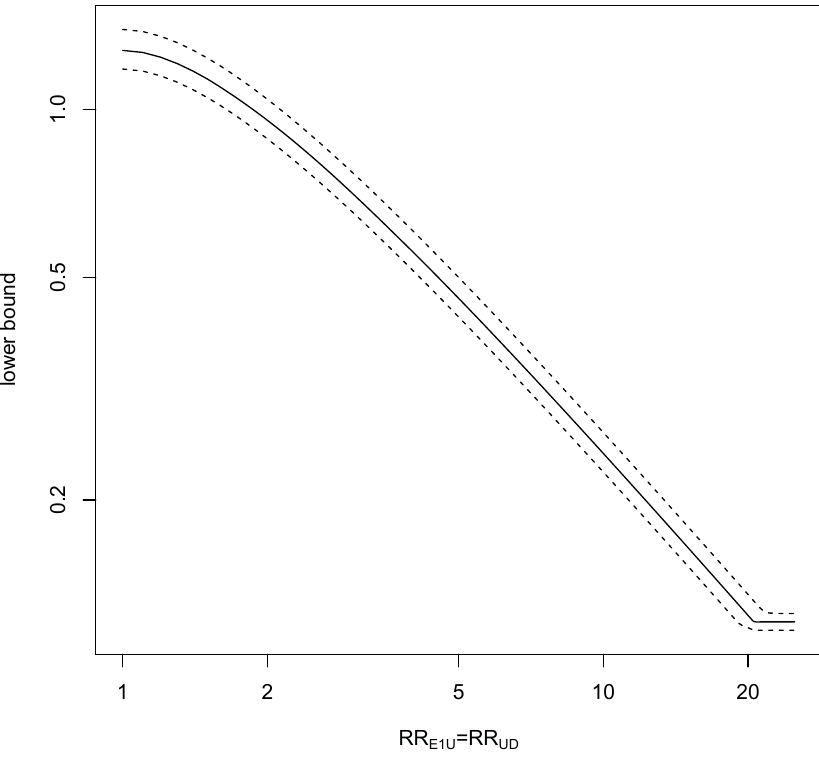
Figure 3: Estimated maximal value of DV’s lower bound and the assumption free bound (solid curve), together with nonparamet- ric 95% bootstrap confidence intervals (dashed curves). Both axes use logarithmic